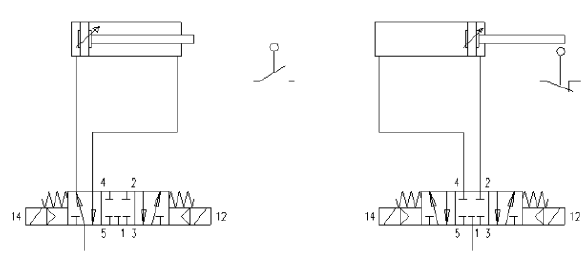
Fig. 1. Interruption of air supply if valve has switched [3]